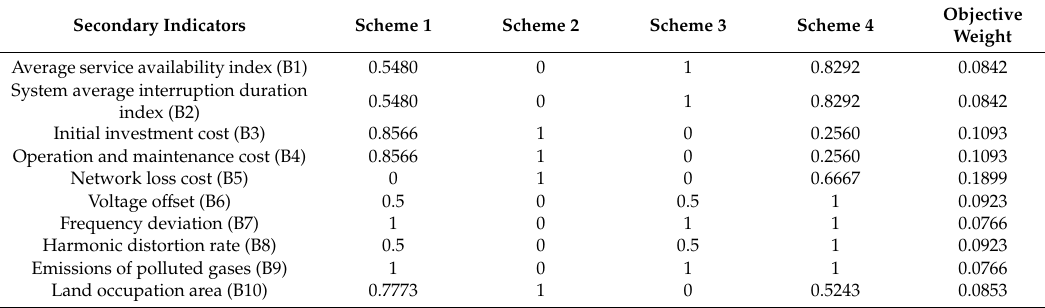
Table 6. Standardized data and objective weights.